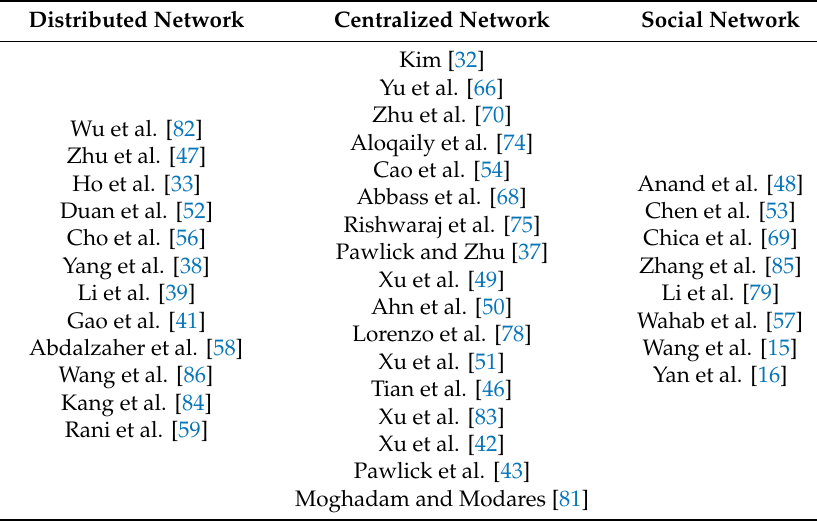
Table 3. Classification of application